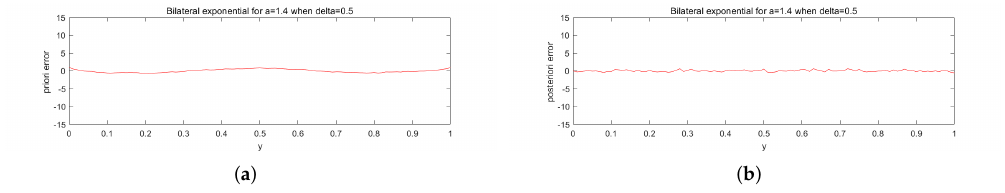
Figure 14. ( a ) A priori error. ( b ) A posteriori error. The errors of f ( x ) when δ = 0.5, α = 1.4 .